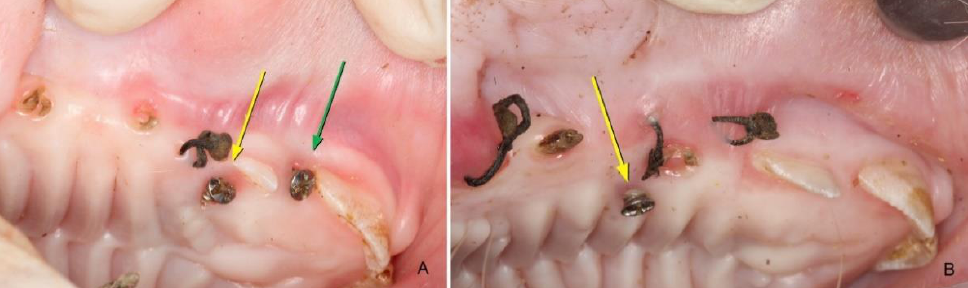
Figure 4. ( A , B ). Graft condition 45 days after surgical placement. The yellow arrows indicate the location of ACTG, and the green arrows indicate MD. The grafted areas presented a clinical healed appearance in comparison with adjacent tissues, only the tissue surrounding the screws presented a slightly edematous aspect and higher accumulation of plaque.